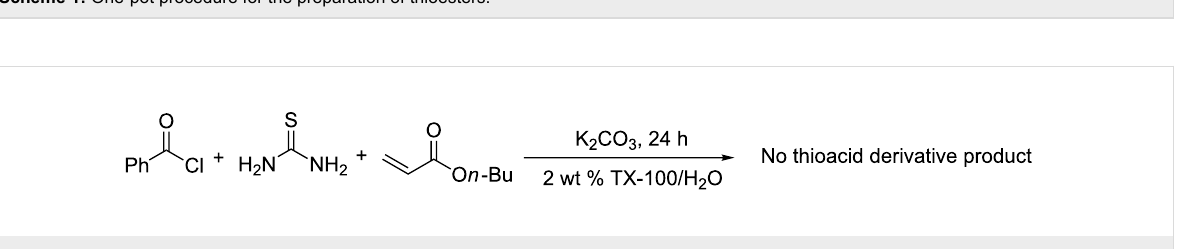
Scheme 2: Reaction of benzoyl chloride, thiourea and butyl